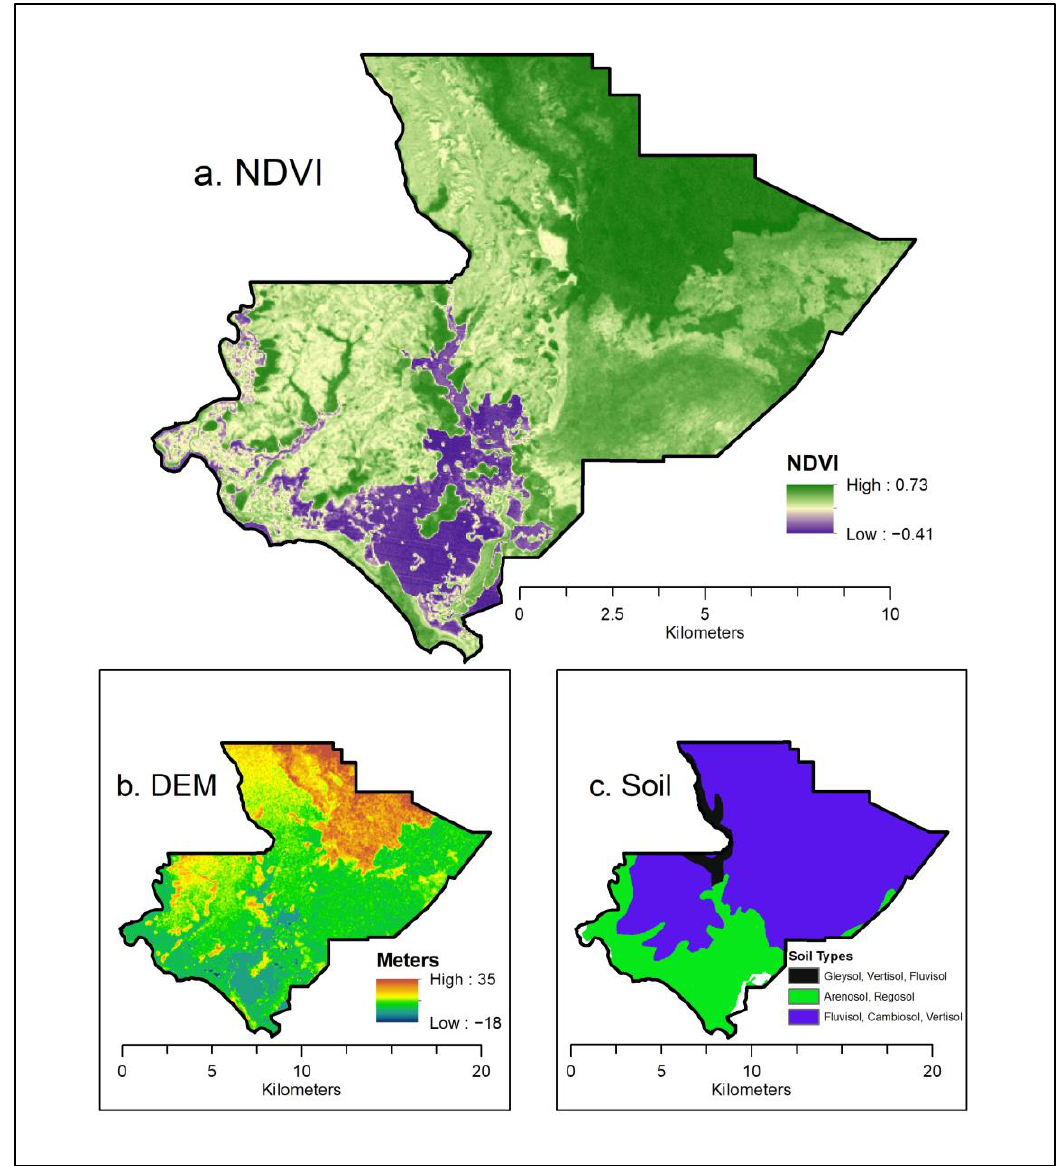
Figure 3. Maps of data used as variables in the Support Vector Machine (SVM) classification: ( a ) Normalized Difference Vegetation Index (NDVI) map of Landsat-5 Thematic Mapper (TM) image from March 2011; ( b ) Shuttle Radar Topography Mission (SRTM) Digital Elevation Model (DEM) showing elevation in meters of PCNP, from United States Geological Survey (USGS) Earth Explorer; ( c ) soil type map showing areas in PCNP with differing major soil types, from Selva Maya consortium.